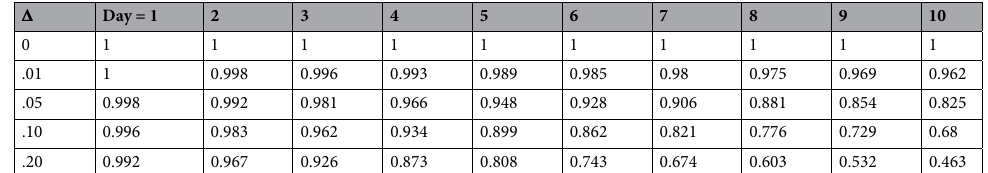
Table 2. Example: Estimating the effect of a mobility-reducing policy on infections for the global model (unit of observation is a country day). The values in the table are the ratio of the cumulative number of cases after up to 10 days, if residential time over baseline was increased in a country at day 0 by (cid:31) = 1%, 5%, 10% or 20% from their original values. These values are estimated using coefficients of the mobility variables derived from the pooled global model (details in “Supplementary file 1: Appendix B.2”). Note that each column compares to the value on its first row (indicated by the value 1). An example interpretation is: if a country increases residential time by 5%, cumulative infections ten days later is predicted to be 82.5% of what they would have been with no change in